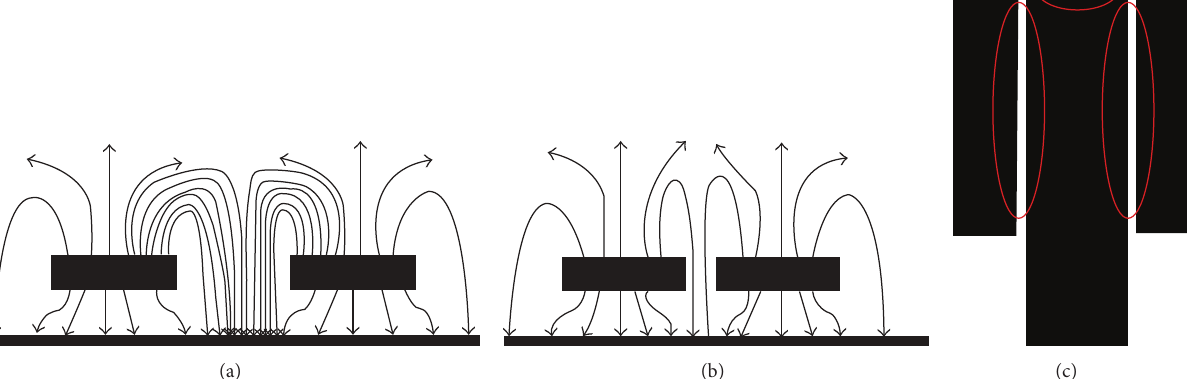
Figure 3: (a) Wide coupling gap; (b) narrowed coupling gap; (c) points of coupling at the patch of the resonator.